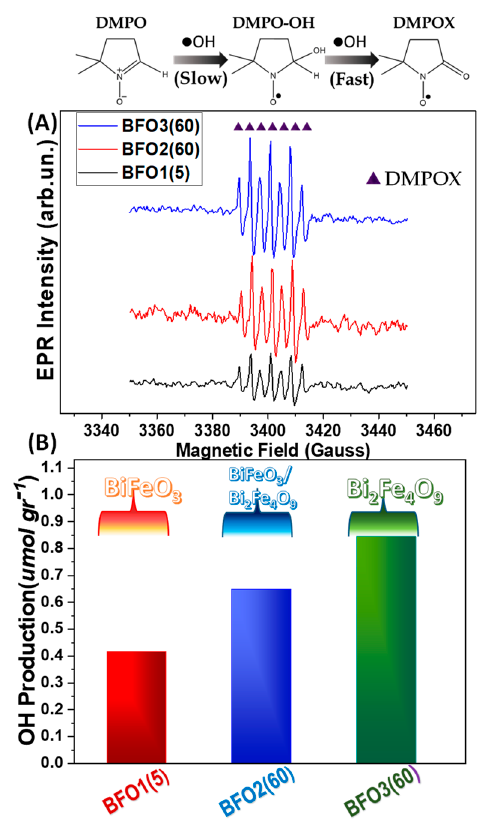
Figure 6. ( A ) EPR spectra of photogenerated OH-radicals for the three best-performing BFO mate- rials. The detected EPR signals correspond to DMPOX states which is a result of two ● OH trapped per DMPO molecule. ( B ) Quantitative ● OH-production per gram of photocatalyst.